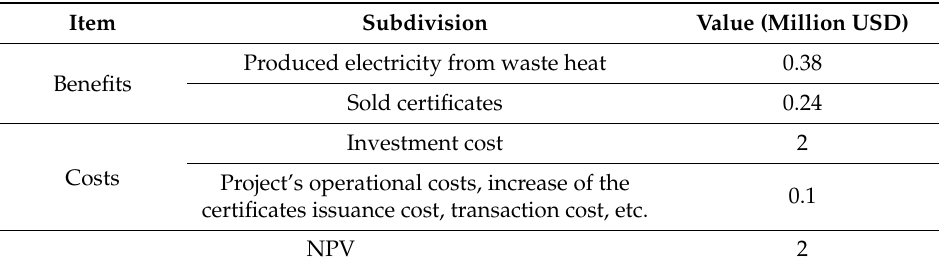
Table 3. The magnitude of cash flows by implementation of one MW